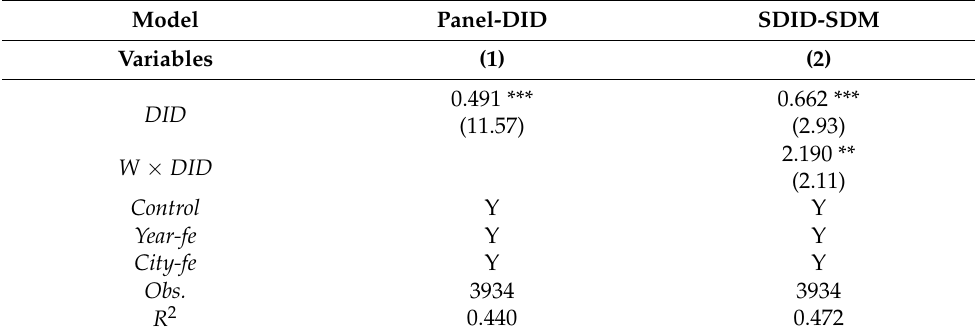
Table 1. Baseline regression results.